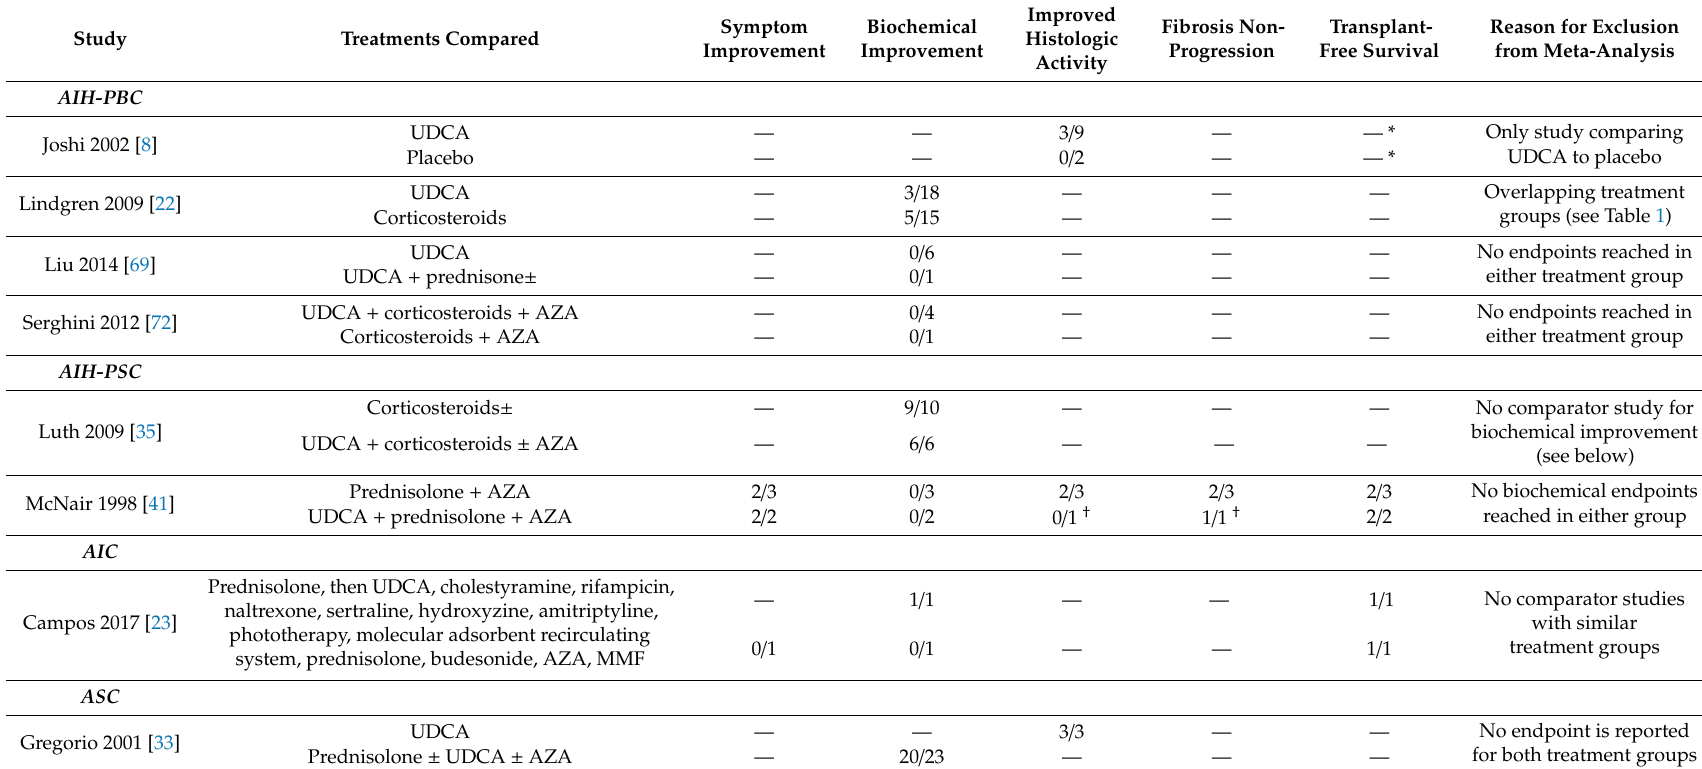
Table 3. Results of studies included in systematic review but excluded from